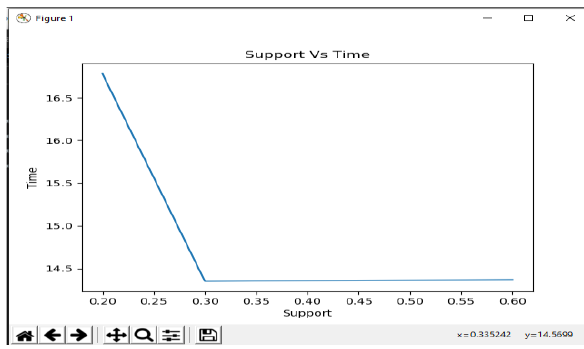
Fig 10:- FP-Growth of Online Retail II